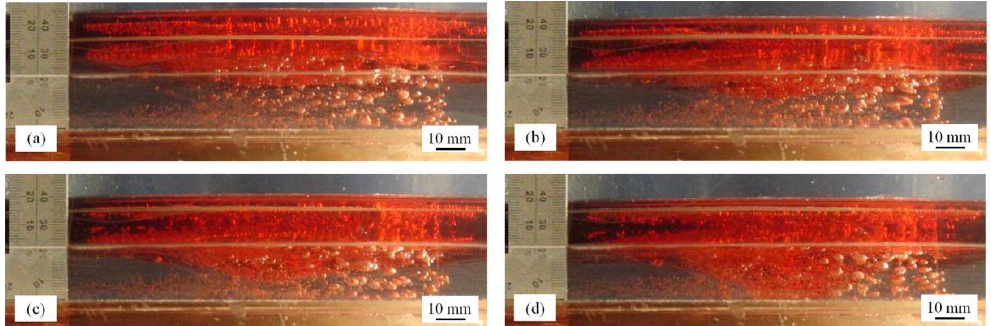
Figure 5. Behavior of controlling slag carry-over of the new process with argon injected into the ladle around the tapping hole at bath heights: ( a ) 26 mm, ( b ) 23 mm, ( c ) 21.5 mm, and ( d ) 20.5 mm.